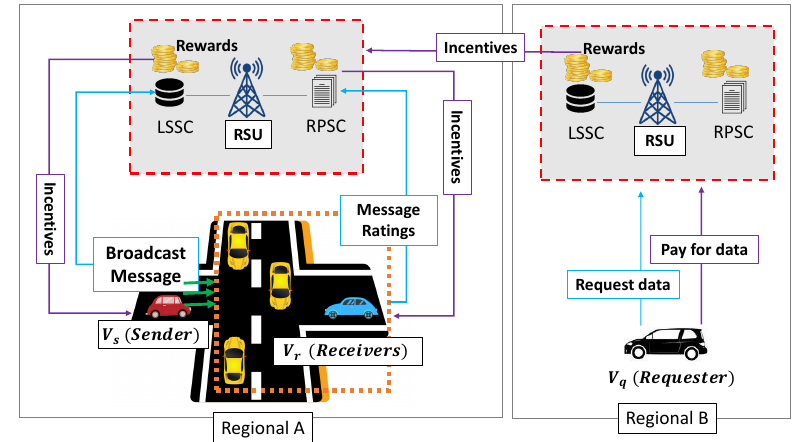
Figure 4. Illustration of incentive